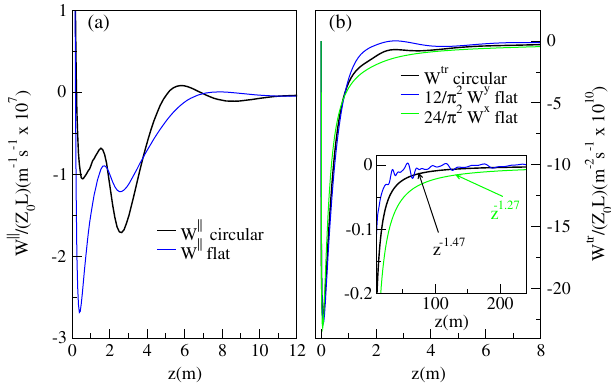
FIG. 7. Comparison between circular (black) laminated cham- ber and parallel-plane (blue) laminated chamber wake functions. (a) Longitudinal wake. (b) Transverse wake. The horizontal (green) [vertical (blue)] flat chambers wake is multiplied by a ( 12 ). Inset: The long distance behavior of transverse factor of 24 (cid:2) 2 (cid:2) 2 wakes. In our example the wake for round chamber decays as z (cid:1) 1 : 47 while the horizontal wake for flat chamber decays